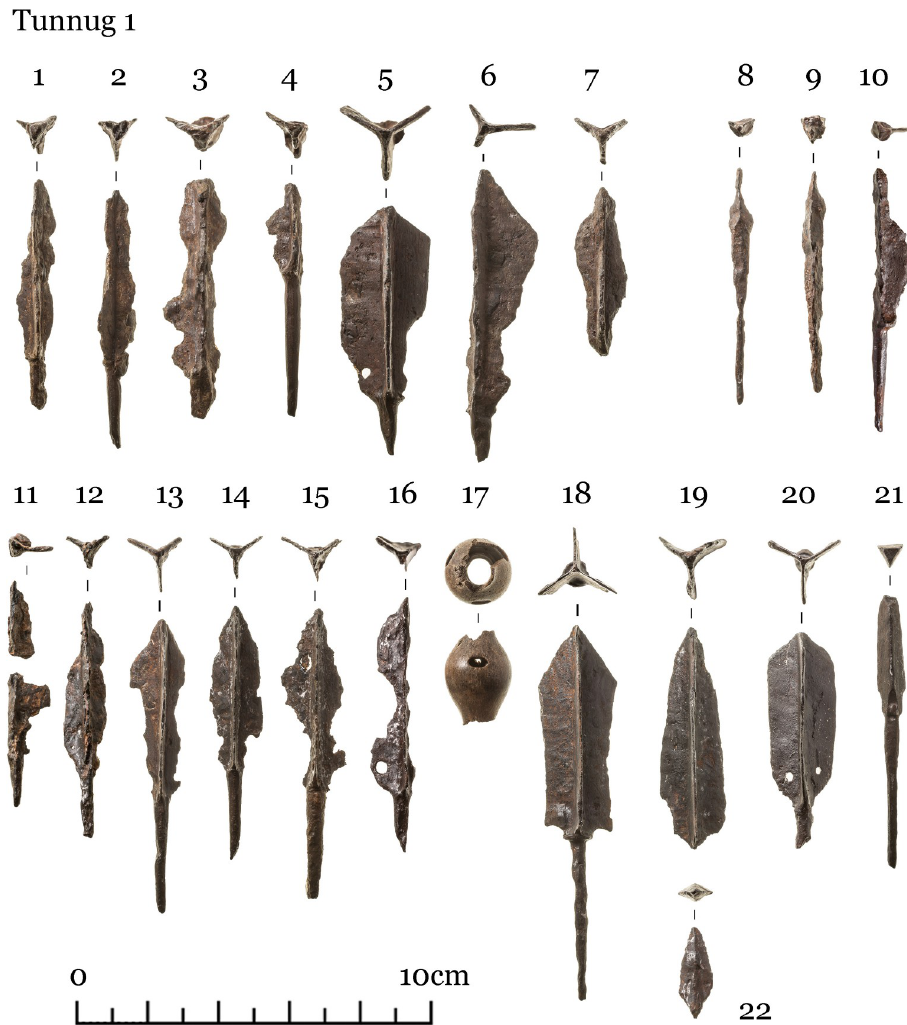
Fig 7. Tunnug 1. Medieval artifacts.